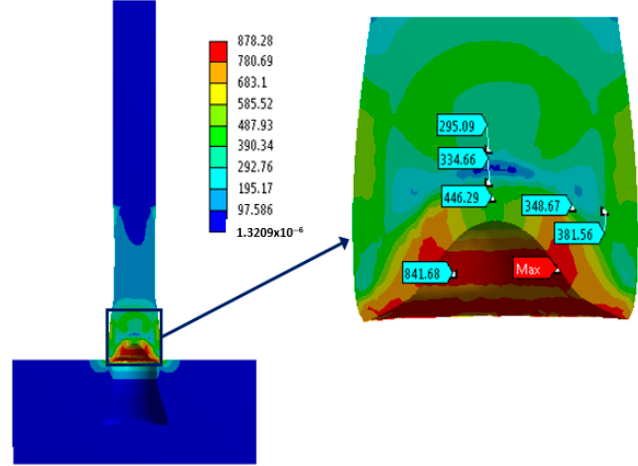
Figure 8. FE model of joint failure.